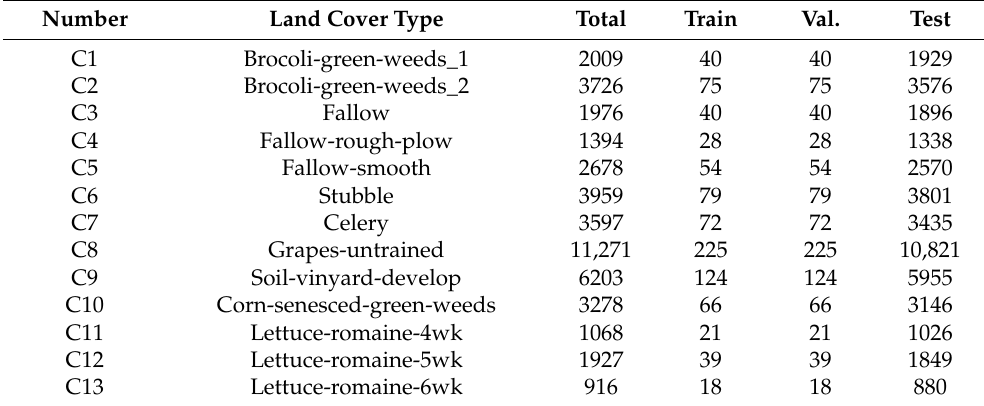
Table 10. The number of total samples, training samples, validation samples, and testing samples for each category of the SV